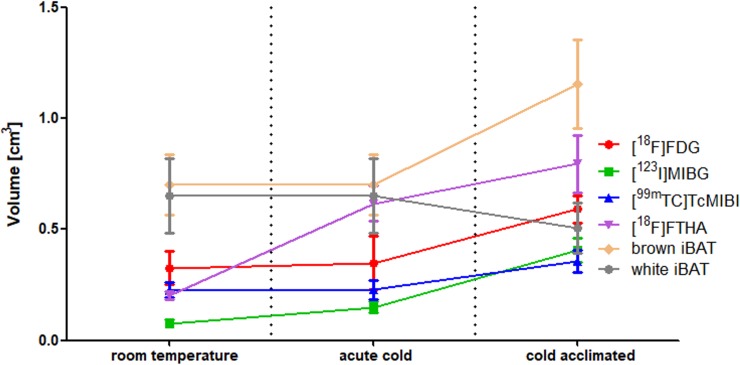
iBAT metabolic volumes of [18F]FDG, [18F]FTHA, [123I]MIBG and [99mTc]TcMIBI, as well as iBAT and iWAT volume determined by dissection, in different temperature conditions.